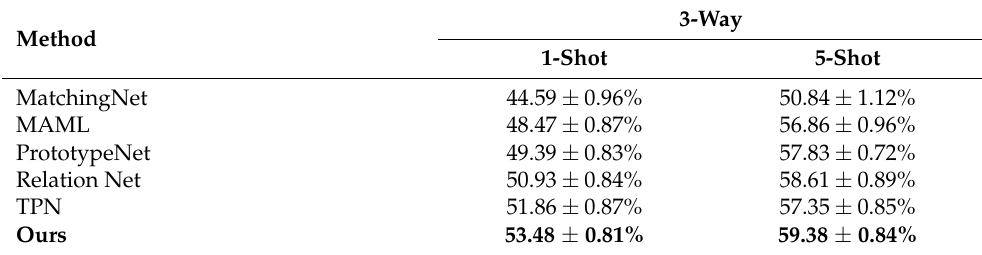
Table 4. The accuracy comparison of different methods on the OrganMNIST dataset.